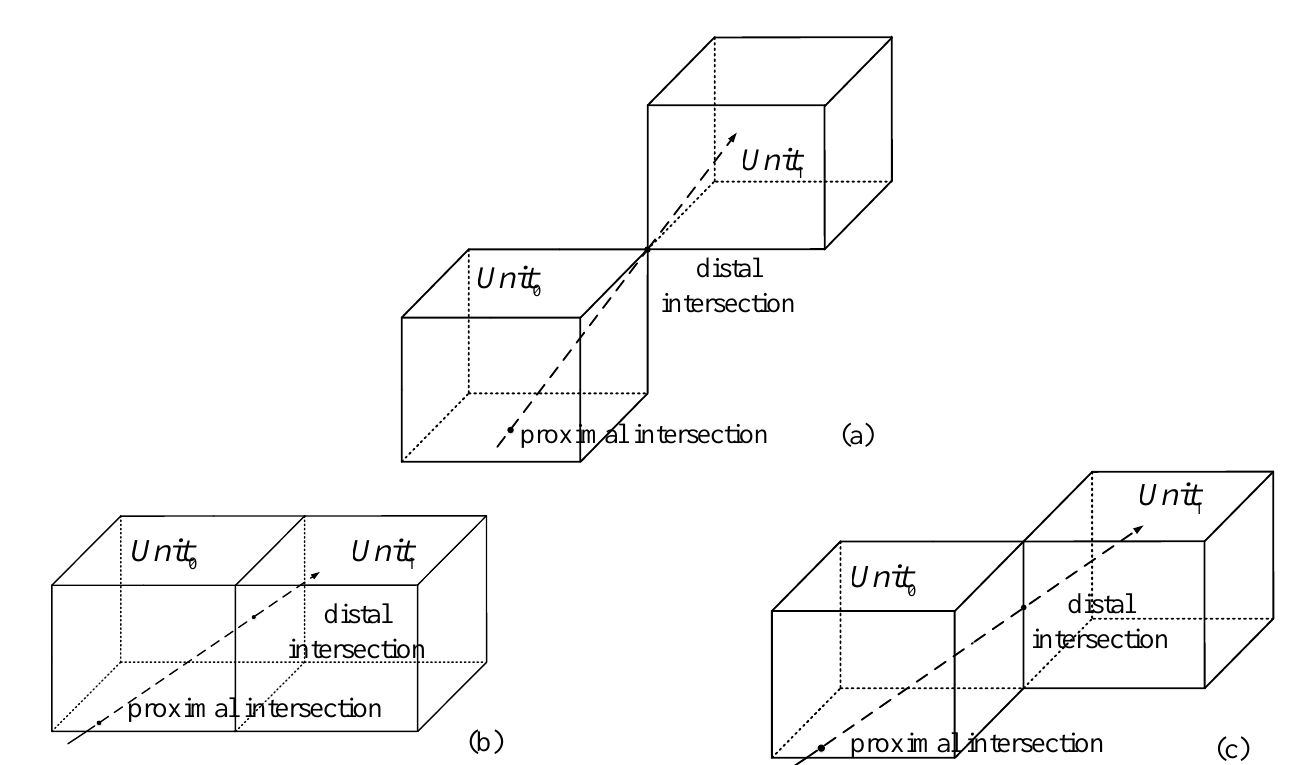
Figure 4. Intersection of ray and SRU: ( a ) ray passes through the vertex; ( b ) ray passes through the surface; ( c ) ray passes through the edge.